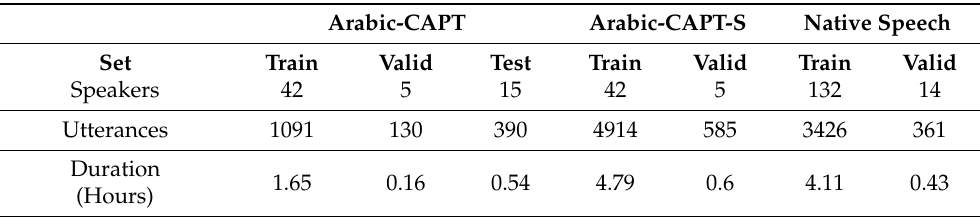
Table 8. Specifications of the developed corpora used in the training and testing phases.